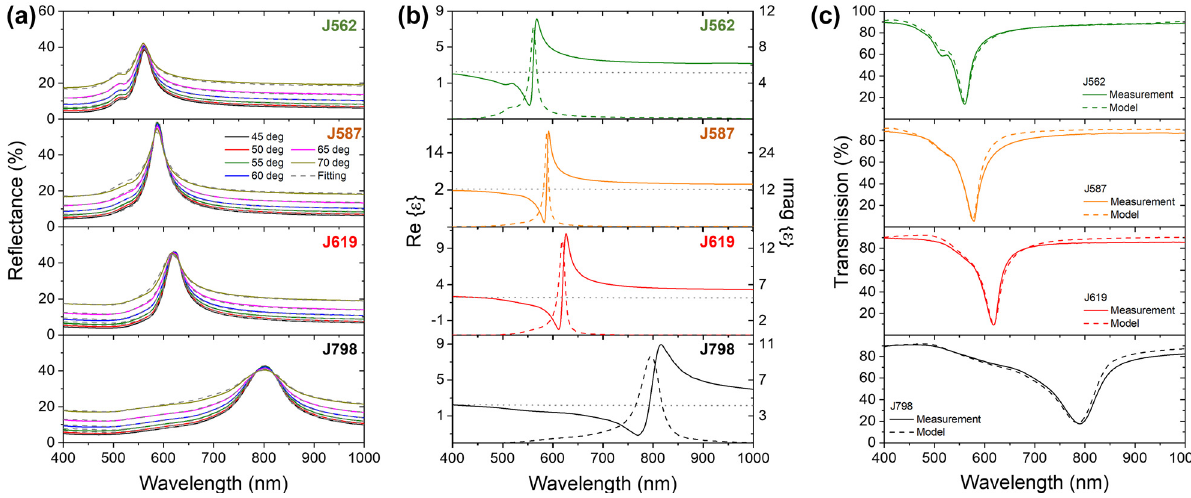
Figure 2: Optical response and optical properties of J-aggregate:PVA films. (a) Measured (solid lines) and fitted data (dashed lines) of un-polarised reflectance of J-aggregate:PVA films at an angle of incidence of 45, 50, 55, 60, 65 and 70 ◦ . (b) Real (solid line) and imaginary (dashed line) parts of the permittivity for the different J-aggregate:PVA films as indicated obtained by fitting the unpolarised reflectance data only. Real part of the permittivity of PVA from published data (grey dotted line) [42]. (c) Experimental and modelled transmission through the polymer films using the optical properties obtained from reflectance and the thickness from AFM. Panels from top to bottom: J562, J587, J619 and J789 films. Table 1: Roughness ( 𝜎 ), thickness, polaritonic band, full half maximum width (FHMW) and minimum value of real part of permittivity ( 𝜀 1(min)) of the J-aggregate:PVA films obtained with the different